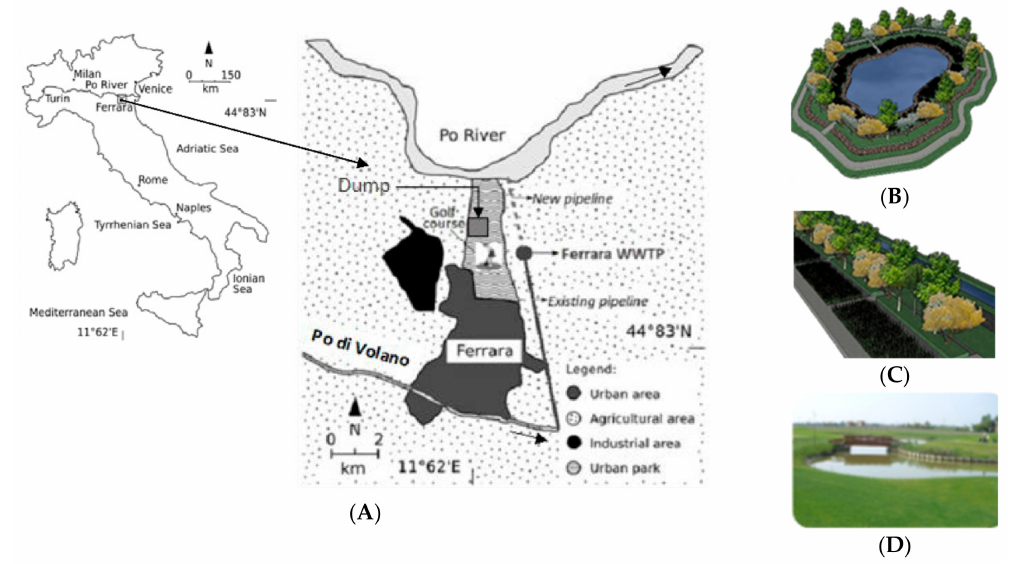
Figure 1. The study area; ( A ) map of the area under study and soil destination; ( B ) cycle path; ( C ) cycle path; ( D ) pond in the urban